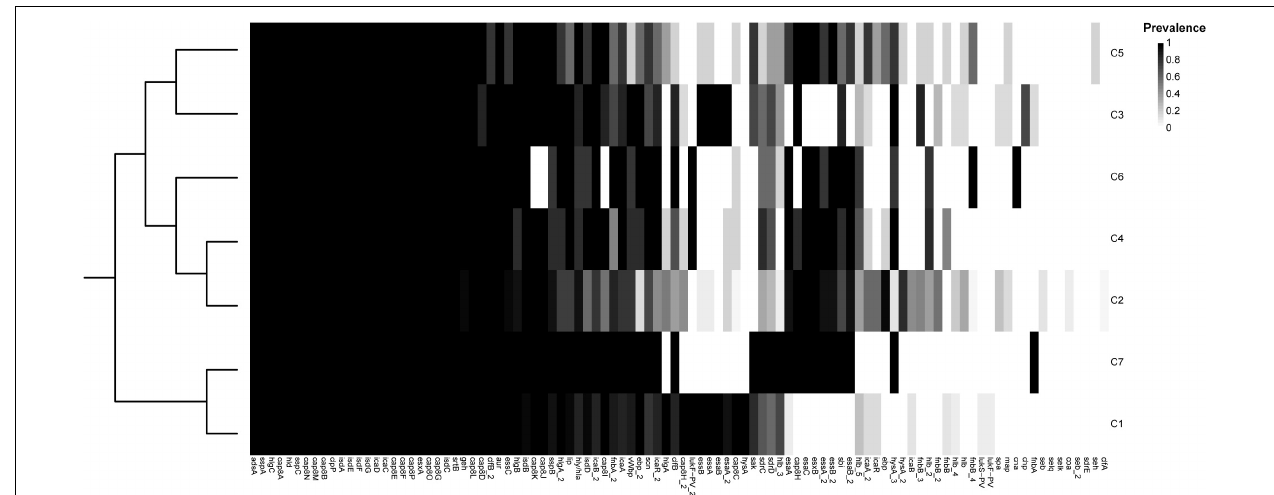
FIGURE 3 | Prevalence of different virulence genes in each of the S . argenteus